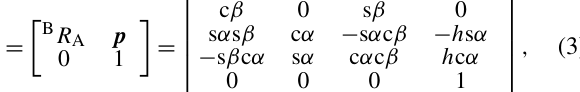
to the right-hand rule. The coordinate system of the moving platform A 1 A 2 A 3 A 4 is established with the geometric center of A in the mechanism, and the directions of u axis and v axis on the coordinate system are parallel to AA 4 or AA 1 . Sim- ilarly, the w axis is determined according to the right-hand rule (as shown in Fig.